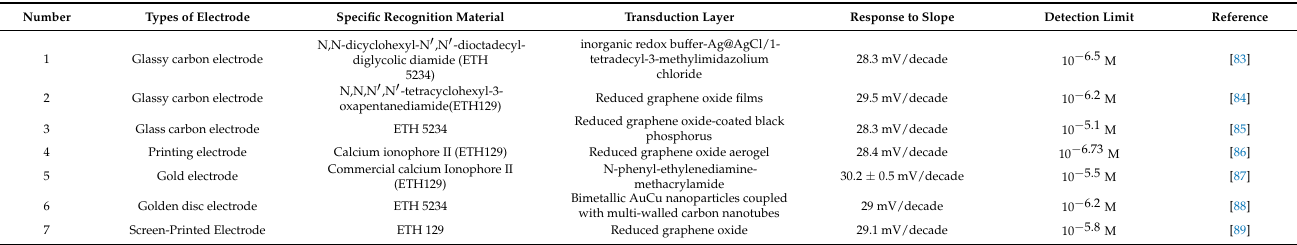
Table 2. List of calcium ISE research status.